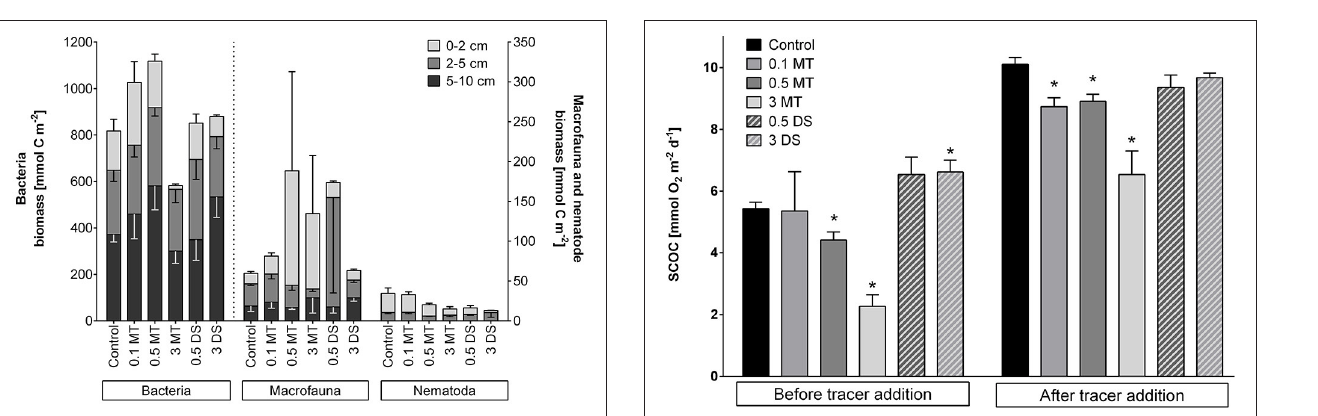
FIGURE 7 | Mean sediment community oxygen consumption (SCOC) in mmol O 2 m − 2 d − 1 before and after tracer addition for the different substrate addition treatments. Error bars denote standard error and an asterisk indicates significant ( p < 0.05) differences with the control. Abbreviations: 0.1 MT = 0.1cm mine tailing addition, 0.5 MT = 0.5cm mine tailing addition, 3 MT = 3cm mine tailing addition, 0.5 DS = 0.5cm dead sediment addition, 3 DS = 3cm dead sediment